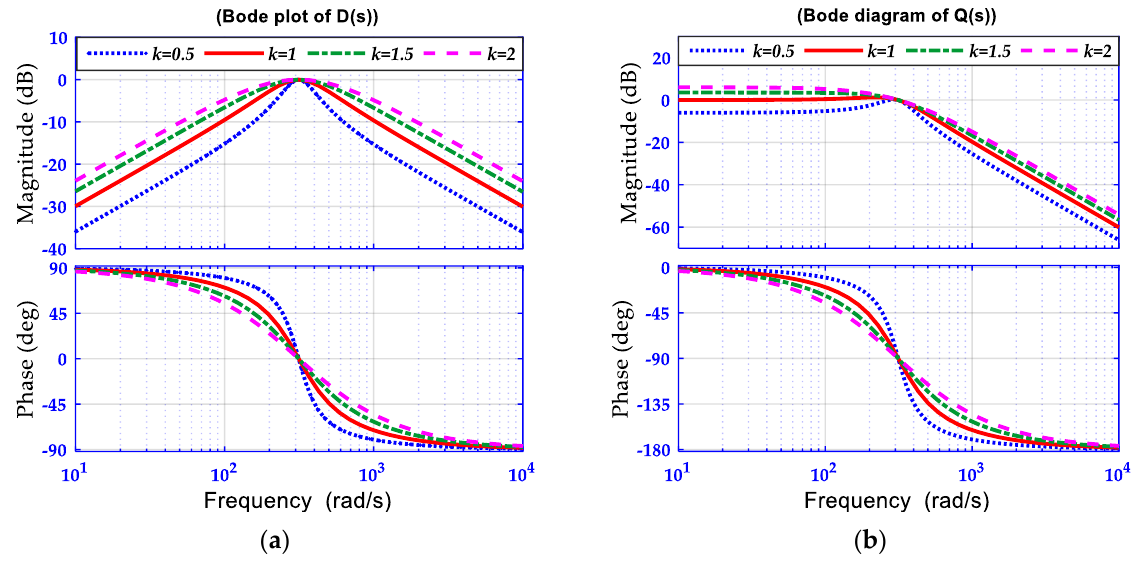
Figure 3. Bode diagrams of: D